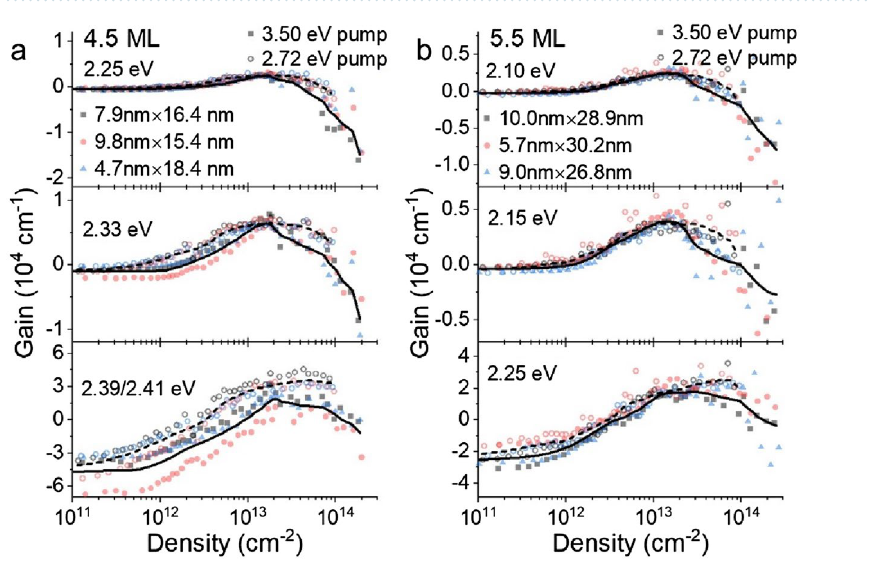
Figure 4. ( a , b ) Line-cuts of gain or loss at 3 ps pump-probe delay for representative energy values as a function of photogenerated sheet density for ( a ) 4.5 ML and ( b ) 5.5 ML CQW samples. In all cases, data for measurements with 3.50 eV pump are shown in solid symbols and data for 2.72 eV measurements are shown in open symbols. A solid line represents a smoothed average of 3.50 eV pump experiments and a dashed line corresponds to the smoothed average of 2.72 eV